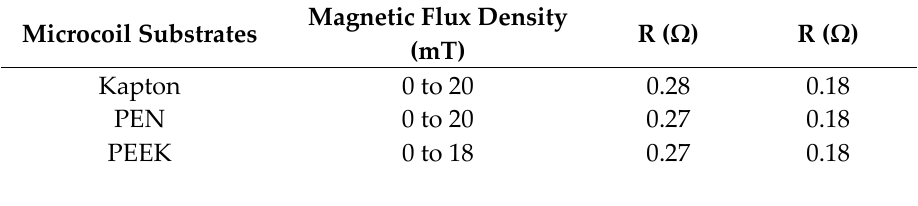
Table 2. Results of simulations with different substrates using